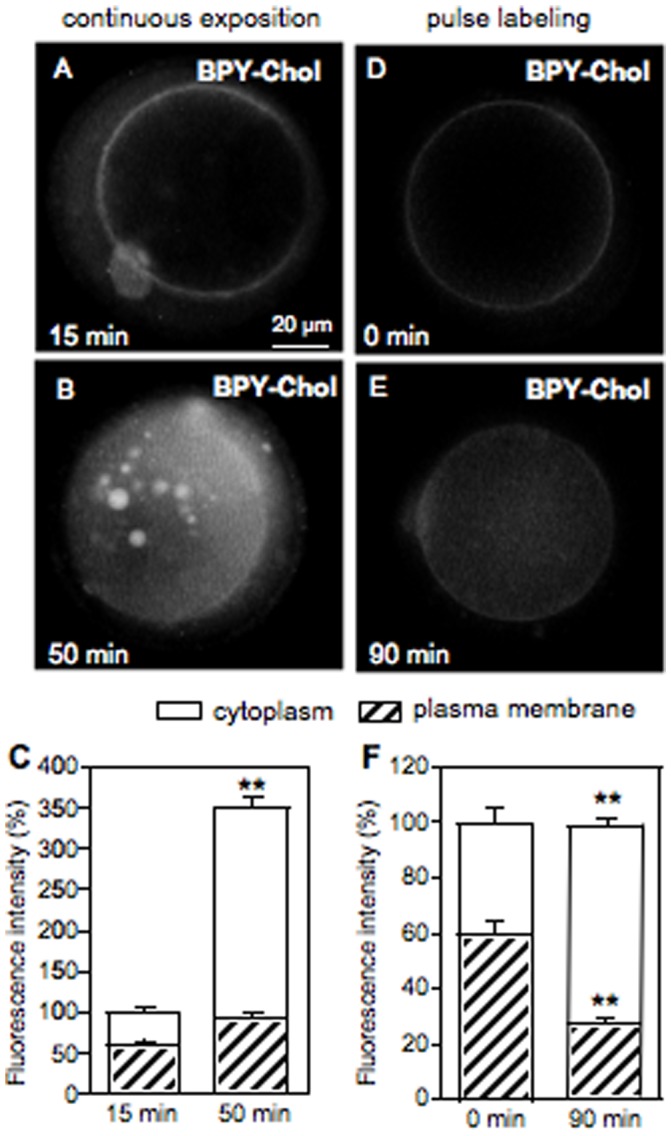
Subcellular localization of BODIPY-Cholesterol in the mouse oocyte.Zona-intact ovulated oocytes were incubated with the fluorescent cholesterol probe for 15 min at 37°C. (A,B) Oocytes continuously incubated with BPY-Chol were imaged at 15 and 50 min. (D,E) Pulse-chase experiment. After incubation, BPY-Chol was washed and followed in time. (C,F) Fluorescence intensity quantified with ImageJ software. The bars represent the mean ± SEM of a total of 15 oocytes for continuous exposition experiment and 15 oocytes for pulse-chase experiment. Comparison of mean values for each subcellular compartment over time was performed using Student t test. Asterisks denote significant differences (P<0.01). Fluorescence of oocytes measured after 90 min was normalized to 100%.